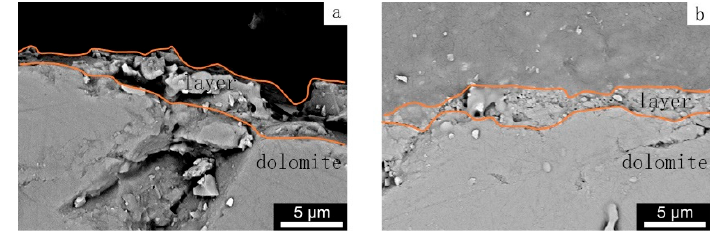
Figure 7. Cross ‐ section of the treated samples: ( a ) AO, ( b ) 0.02 mol/L CA.